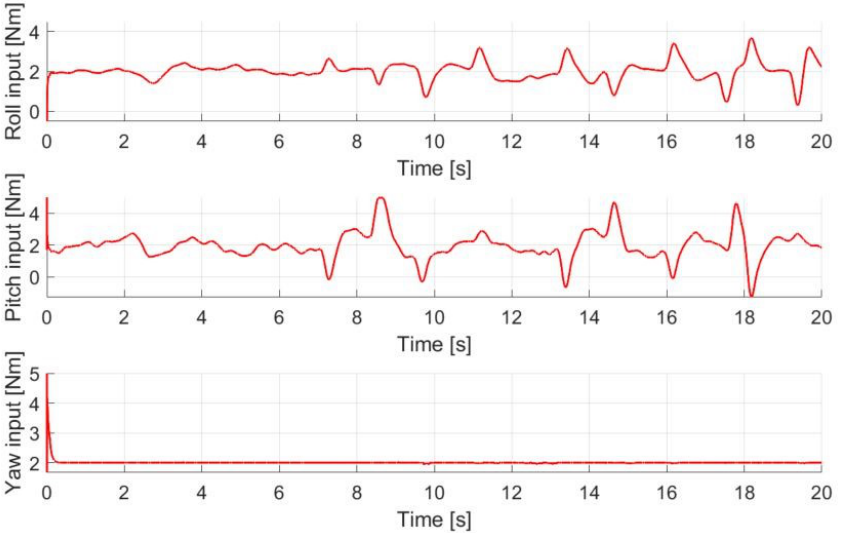
Figure 14. Control efforts with real-time